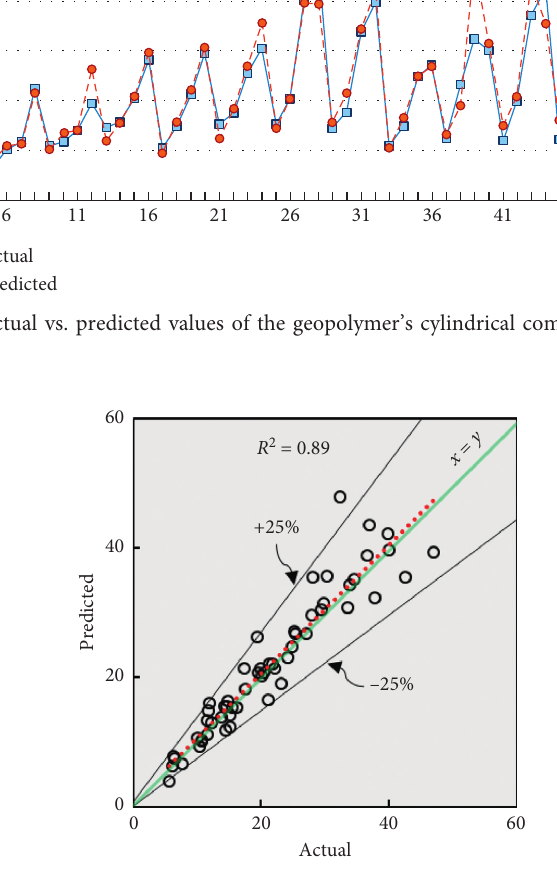
Figure 8: Scatter plot of the actual vs. predicted values of the geopolymer’s cylindrical compressive strength (MPa).